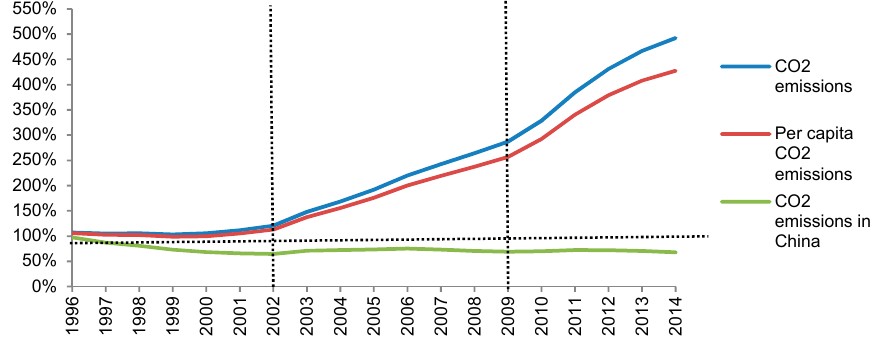
Figure 2. Change rates of CO 2 emissions, per capita CO 2 emissions, and CO 2 emission intensity in Northwest China during 1996–2014 (1996 as the baseline year).